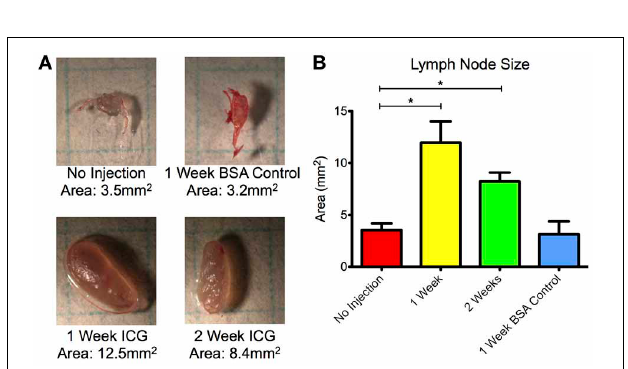
FIGURE 6 | ICG reduces lymphatic function 1 and 2 weeks after initial injection. Compiled (A) transport time, packet frequency during (B) arrival and steady-state (C) , and packet velocity during (D) arrival and (E)